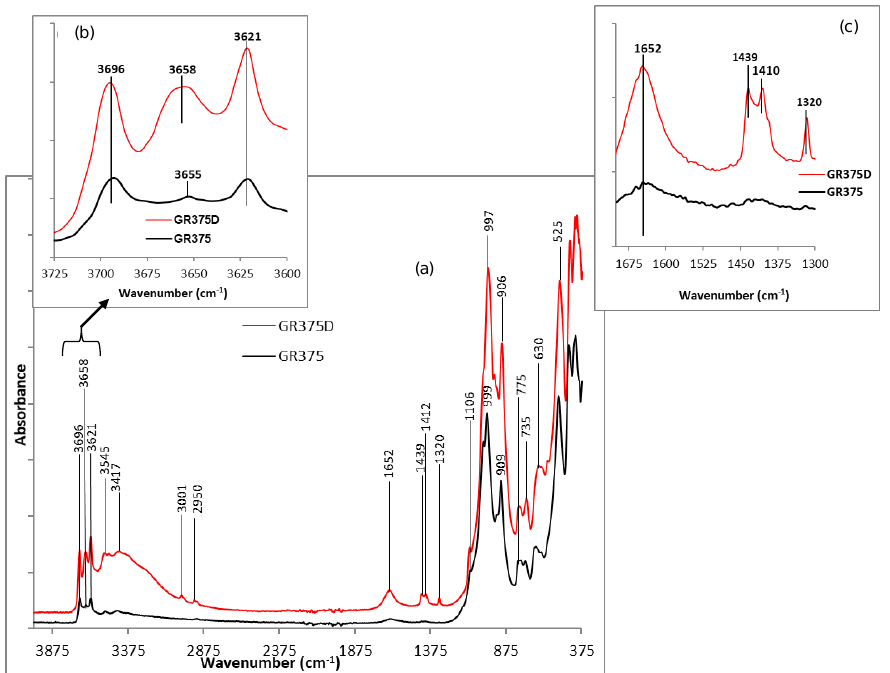
Figure 2. FTIR spectra of the raw sample (GR375) and the DMSO intercalated (GR375-D) ( a ) complete spectra ( b ) zoom of the O–H stretching bands ( c ) zoom from 1675 cm –1 to 1300 cm –1 .